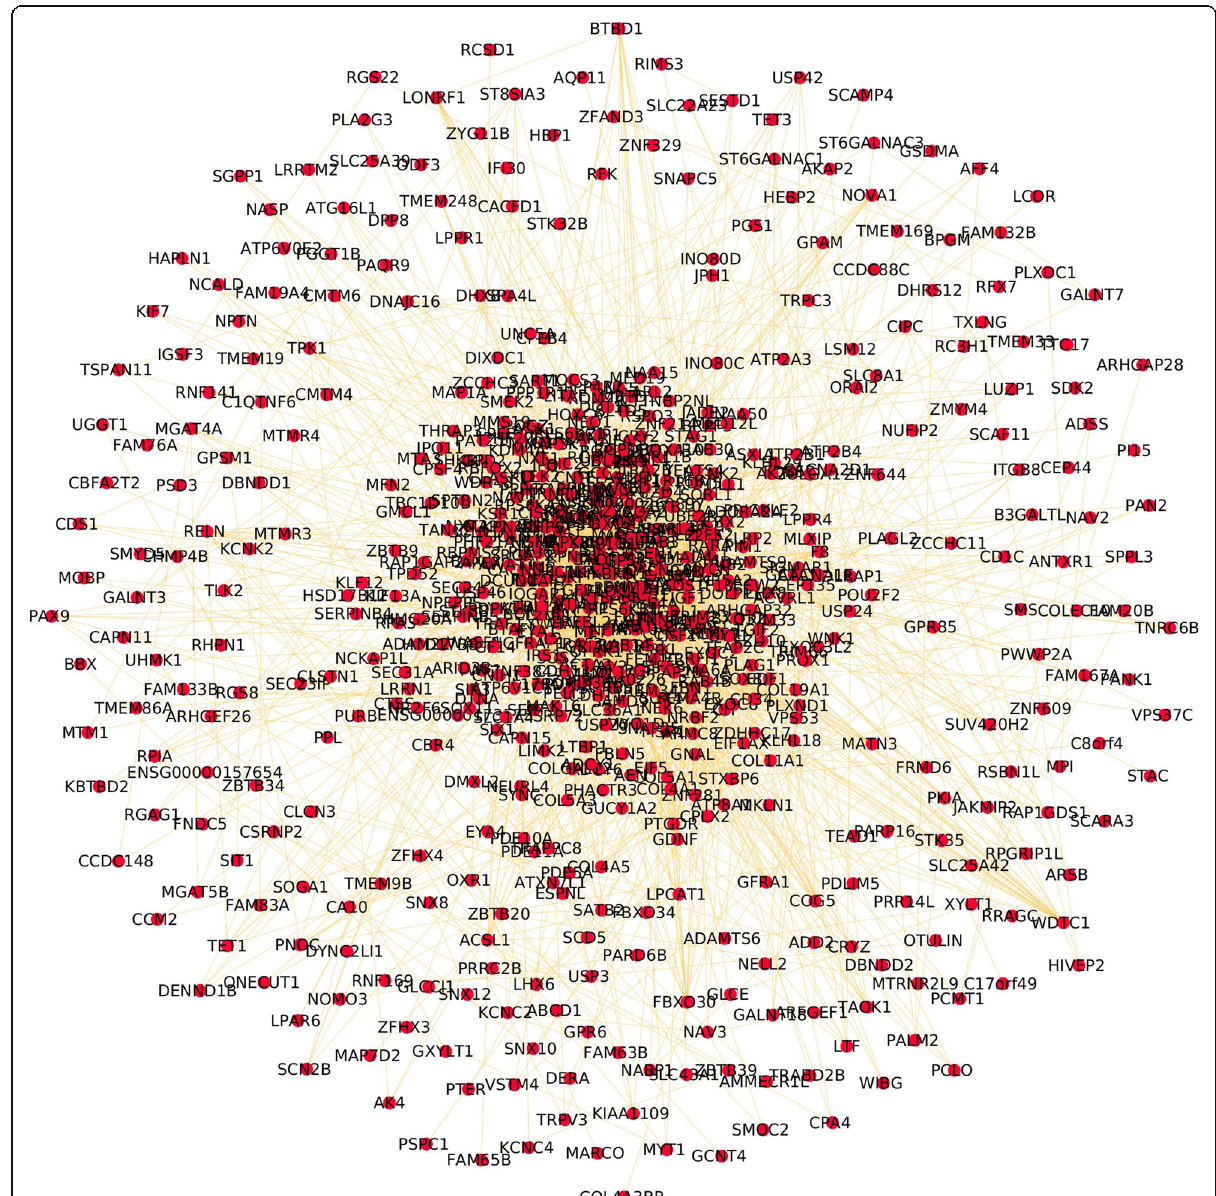
Fig. 3 Results of target gene identification from miRDB and TargetScan